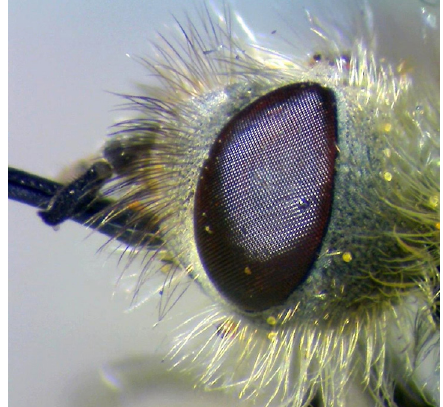
Fig. 23. Protypusia grata (Loew, 1859) gen. et comb. nov., ♀.